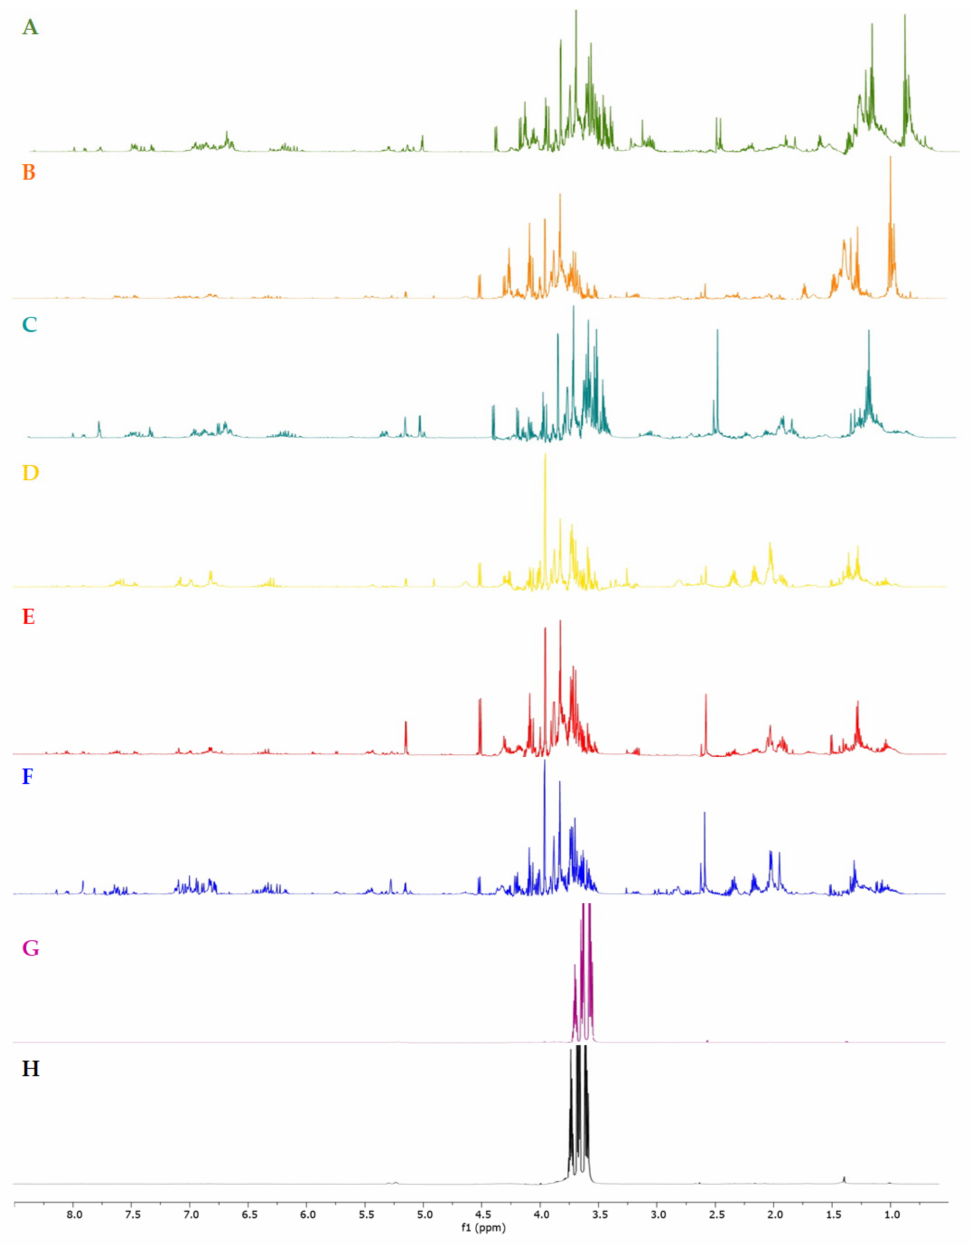
Figure 1. 1 H NMR spectra of the derived food supplements ( A – H ) of H. italicum ( A : 60:40; B : 50:50; C : 46:54; D and E : 45:55; F : 20:80 EtOH-H 2 O extracts; G : glycerol extract; H : water-glycerol